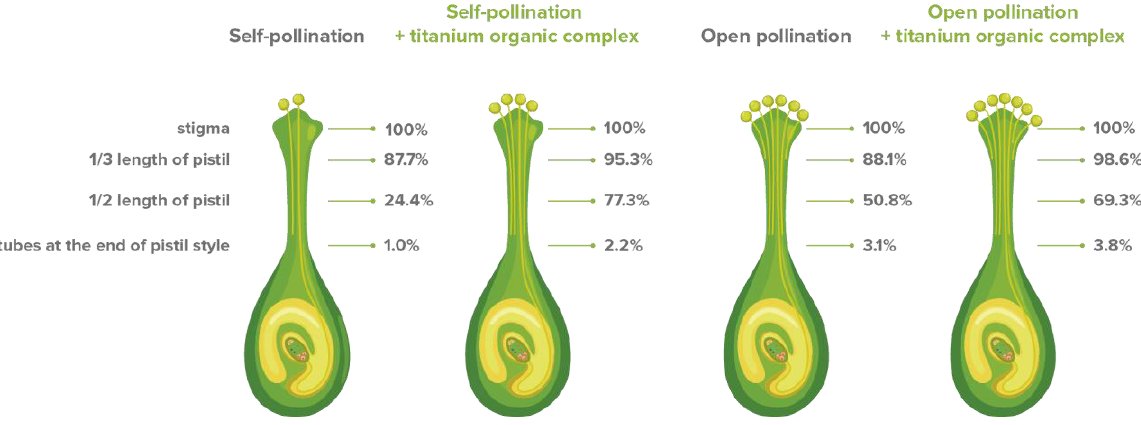
Figure 2. The model of pollen tube growth through pistil neck of apple cv. Topaz, based on the average of two year research.